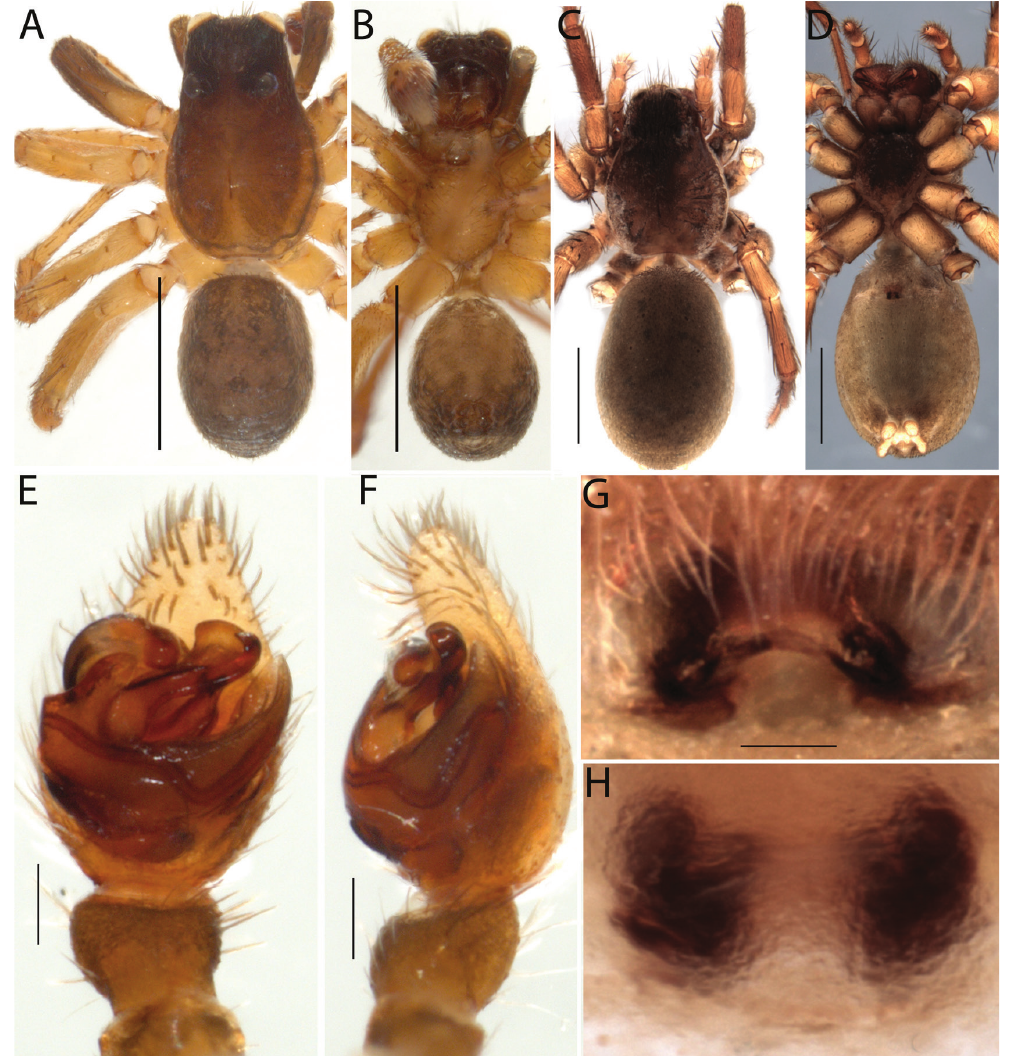
Figure 25. Artoria howquaensis Framenau, 2002, male (AM KS82788), female (WAM T55414): A , male habitus, dorsal view; B , male habitus, ventral view; C , female habitus, dorsal view; D , female habitus, ventral view; E, male pedipalp, ventral view; F , male pedipalp, retrolateral view; G , epigyne, ventral view; H , epigyne, dorsal view. Scale bars: habitus 1.0 mm; pedipalp, epigyne 0.1